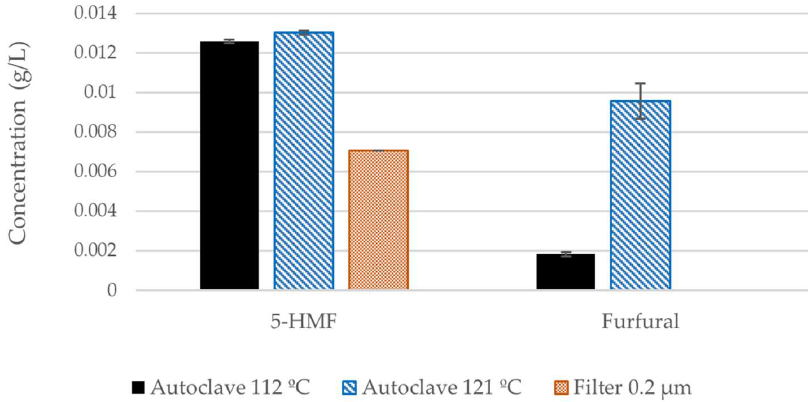
Figure 1. Concentration of 5-HMF and furfural in the cellulose pulp hydrolysate after sterilization by three different methods.